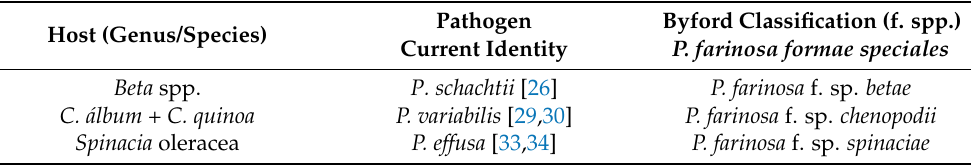
Table 1. Peronospora species current identity and classification by Byford [27,28].